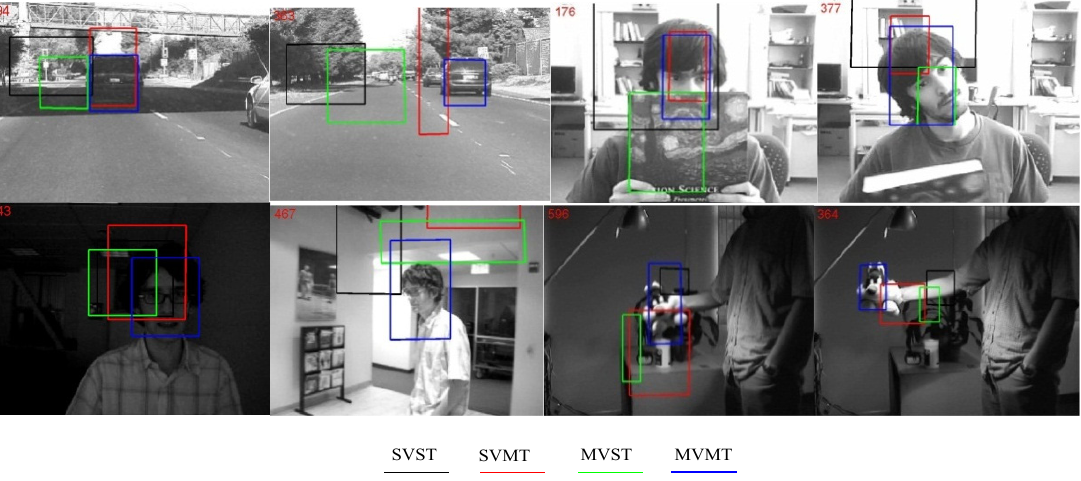
Figure 12. The identification results of the proposed MVMT and SVST, MVST, SVMT algorithms.